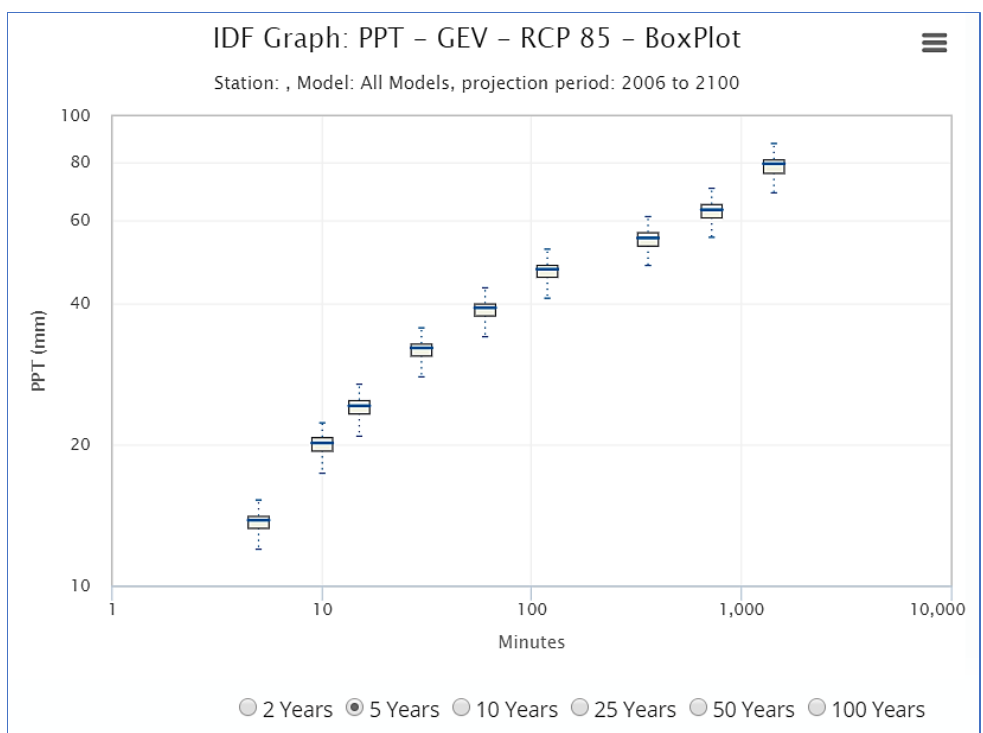
Figure 16. A Box plot of the projected range for the 5-year IDF curve for London station and RCP 8.5 using the 24 raw climate models available within the tool. Water 2020 , 10 , x FOR PEER REVIEW